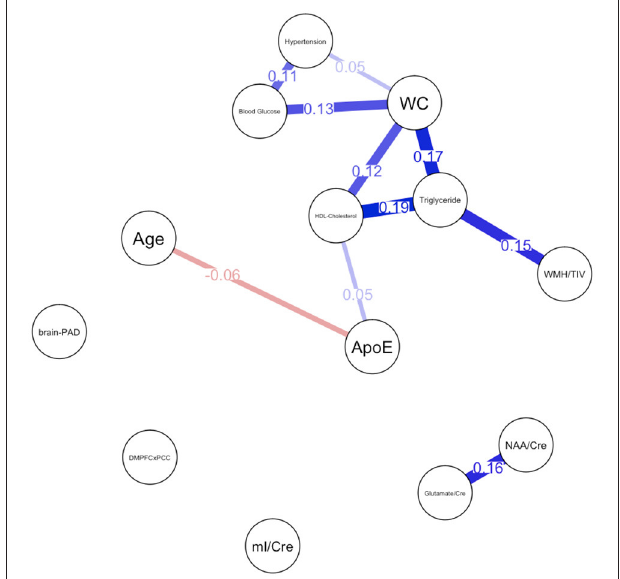
FIGURE 1 | Network plot for males. Brain-PAD, Brain predicted age difference, DMNPFCxPCC, Resting State Functional Connectivity in the Default Mode Network; WC, Waist Circumference; NAA/Cre, Ratio of N-Acetylaspartate to Creatine; mI/Cre, Ratio of Myo-inositol to Creatine; WMH/TIV, White Matter Hyperintensities adjusted for total intracranial volume. Red bars indicate negative correlations and blue bars indicate positive correlations. Thicker, shorter bars indicate stronger relationships. Minimum edge strength set to 0.5 was ignored in network plots because it was larger than the absolute value of the strongest